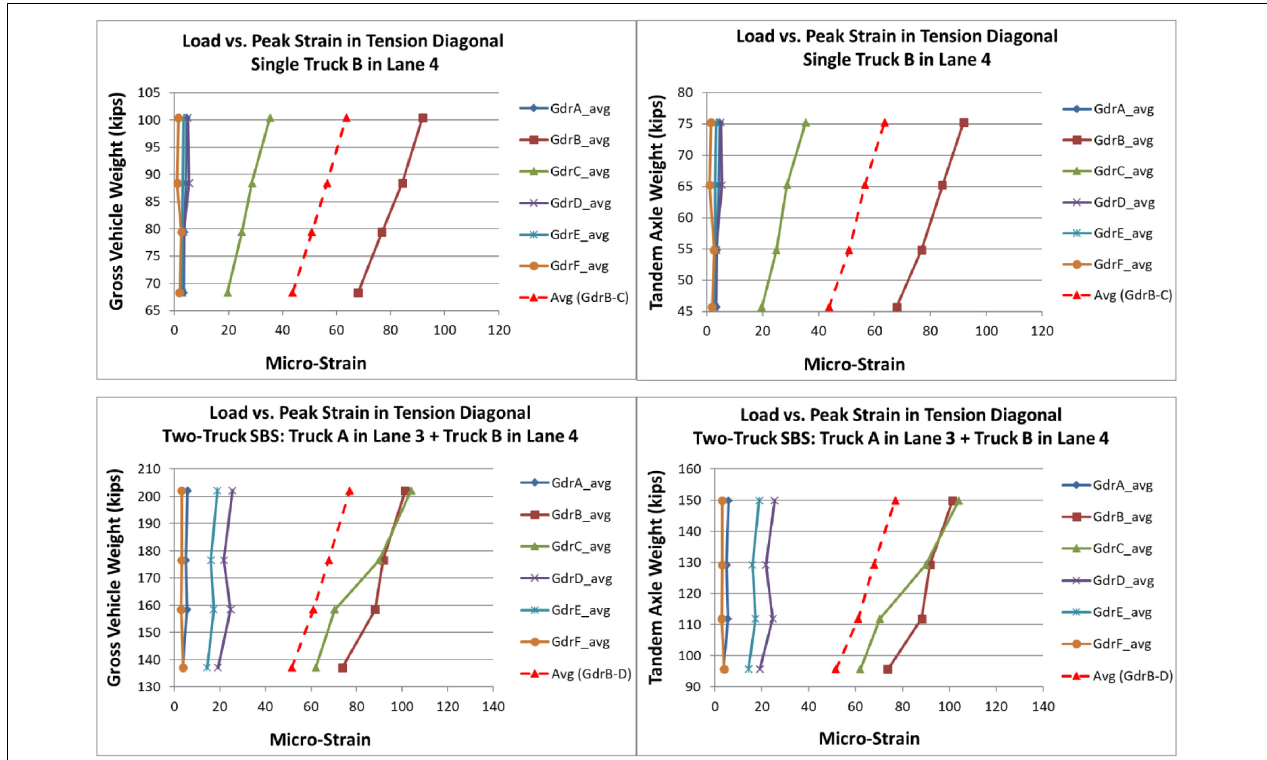
FIGURE 10 | Load vs. peak strain in tension diagonal of dapped end: single truck B in lane 4 test runs (top) and two-truck side-by-side test runs, truck A in lane 3 & truck B in lane 4 (bottom)